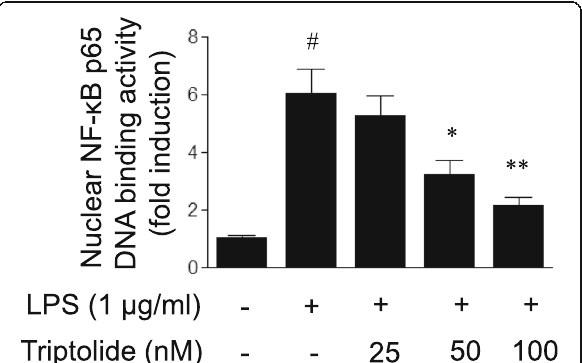
Fig. 6 The effects of triptolide on lipopolysaccharide (LPS)-induced increases in NF- κ B p65 DNA binding activity in human umbilical vein endothelial cells (HUVECs). HUVECs were treated with LPS (1 μ g/ml) in the presence or absence of triptolide (25, 50 or 100 nM) for 30 min. The DNA binding activity of NF- κ B p65 in HUVECs was determined using a non-radioactive, ELISA-based assay kit. Data are expressed as the mean ± standard error of the mean. * p < 0.05 and ** p < 0.01, compared with LPS treatment alone. # p < 0.05, compared with the control group